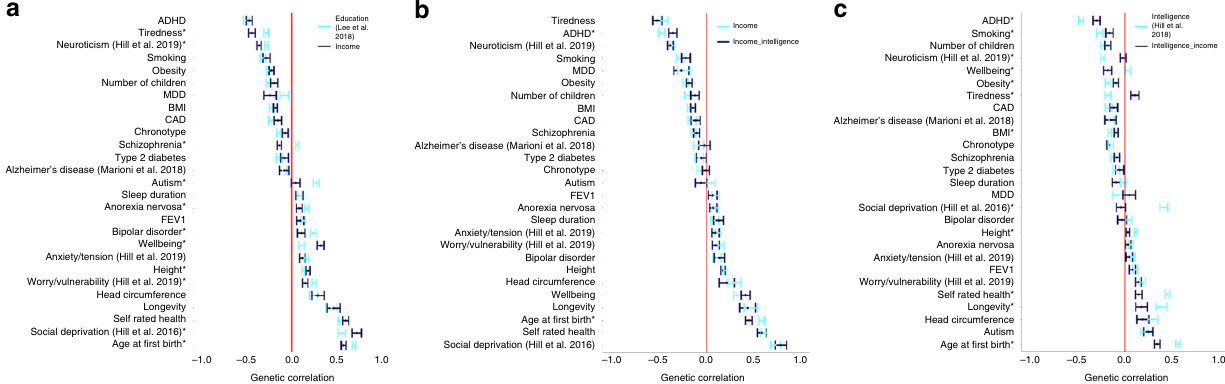
Fig. 6 Pairs of genetic correlations are compared. a compares genetic correlations derived using income with those derived using education, b compares genetic correlations derived using income with those derived using income conditioned on intelligence and c compares genetic correlations derived using intelligence with those derived using intelligence conditioned on income. In each instance, 27 pairs of genetic correlations are compared. Genetic correlations that were signi fi cantly different between within each of the three comparisons described above using a two-sided test (2*pnorm( − abs(abs( r gi − r gj )/sqrt(SE i 2 + SE j 2 )))) are indicated by an asterisk next to the phenotype label. MDD, major depressive disorder; ADHD, attention-de fi cit hyperactivity disorder; T2D, type 2 diabetes; CAD, coronary artery disease; SRH, self-rated health; SWB, subjective well-being; BMI, body mass index: FEV1, forced respiratory volume in 1 second. Worry/ vulnerability and anxiety/tension were derived as special factors of neuroticism 34,92 . Full results for each of the genetic correlations derived can be found in Supplementary Table 12. Error bars represent ( r g = 0.04, SE = 0.05, P = 0.37, P diff = 1.17 × 10 − 11 ). There was